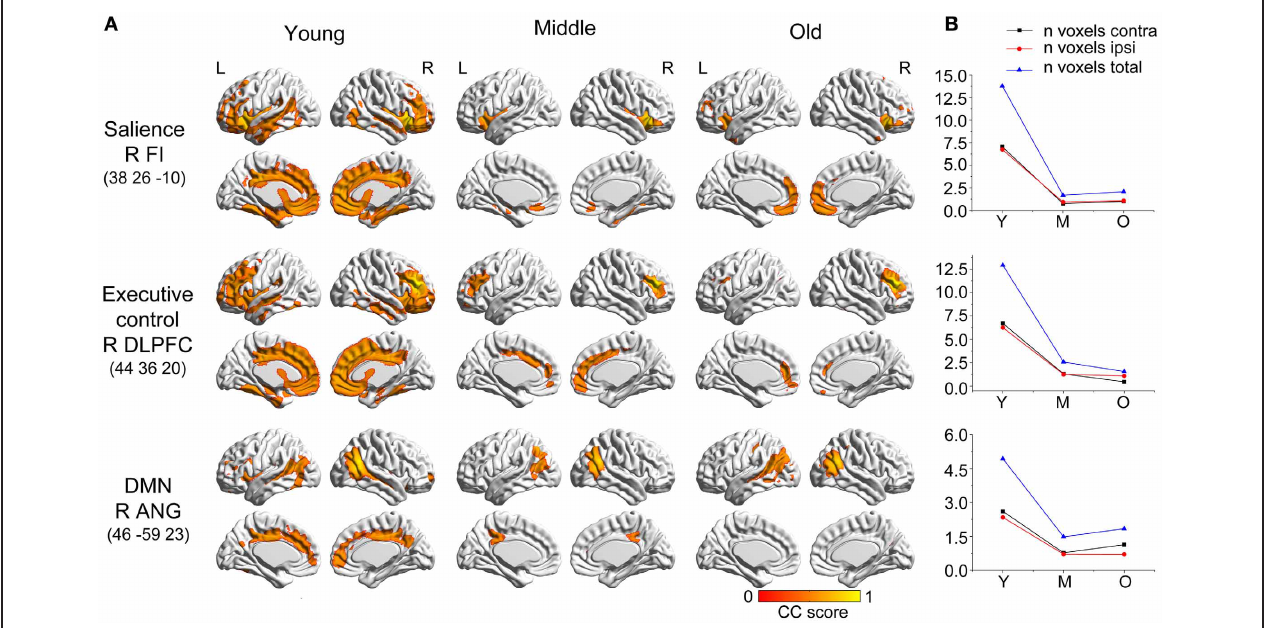
in the middle-aged group and mild changes in the old group. The y-axis represents the voxel number ( × 10 4 ). Abbreviations: DMN, default-mode network; DLPFC, dorsolateral prefrontal cortex; FI, frontoinsular cortex; ANG, angular gyrus; R, right; L, left; Y, young group; M, middle-aged group; O, old group; CC, correlation coefficient.